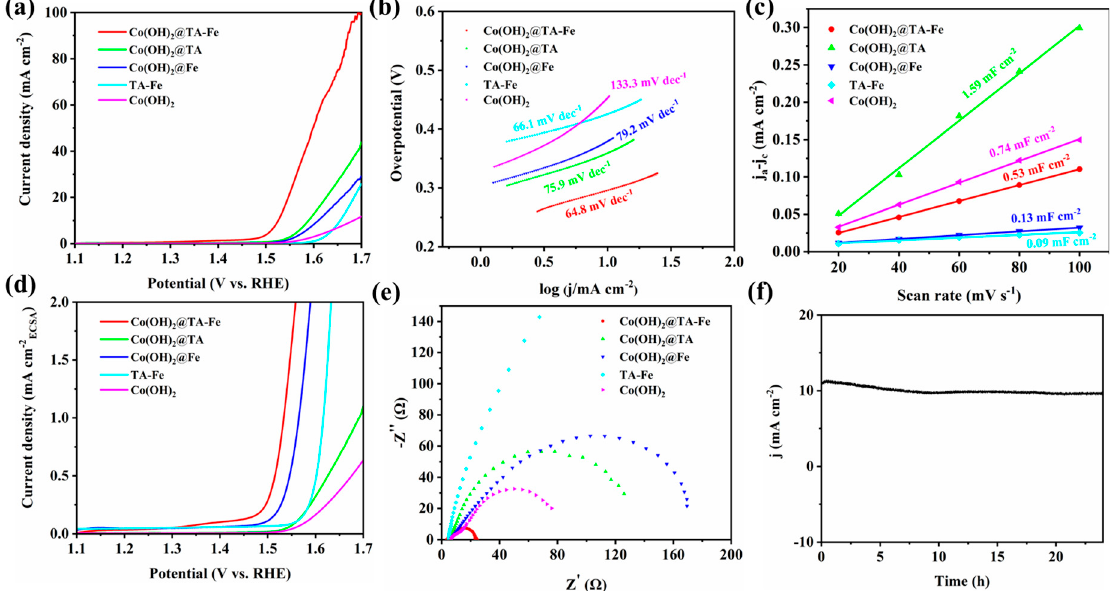
Figure 4. ( a ) LSV curves, ( b ) Tafel slopes, ( c ) C dl calculations, ( d ) LSV curve normalized by ECSA and ( e ) Nyquist plots for Co(OH) 2 @TA − Fe, Co(OH) 2 @Fe, TA − Fe, Co(OH) 2 @TA and Co(OH) 2 . ( f ) Long − term stability of Co(OH) 2 @TA − Fe.